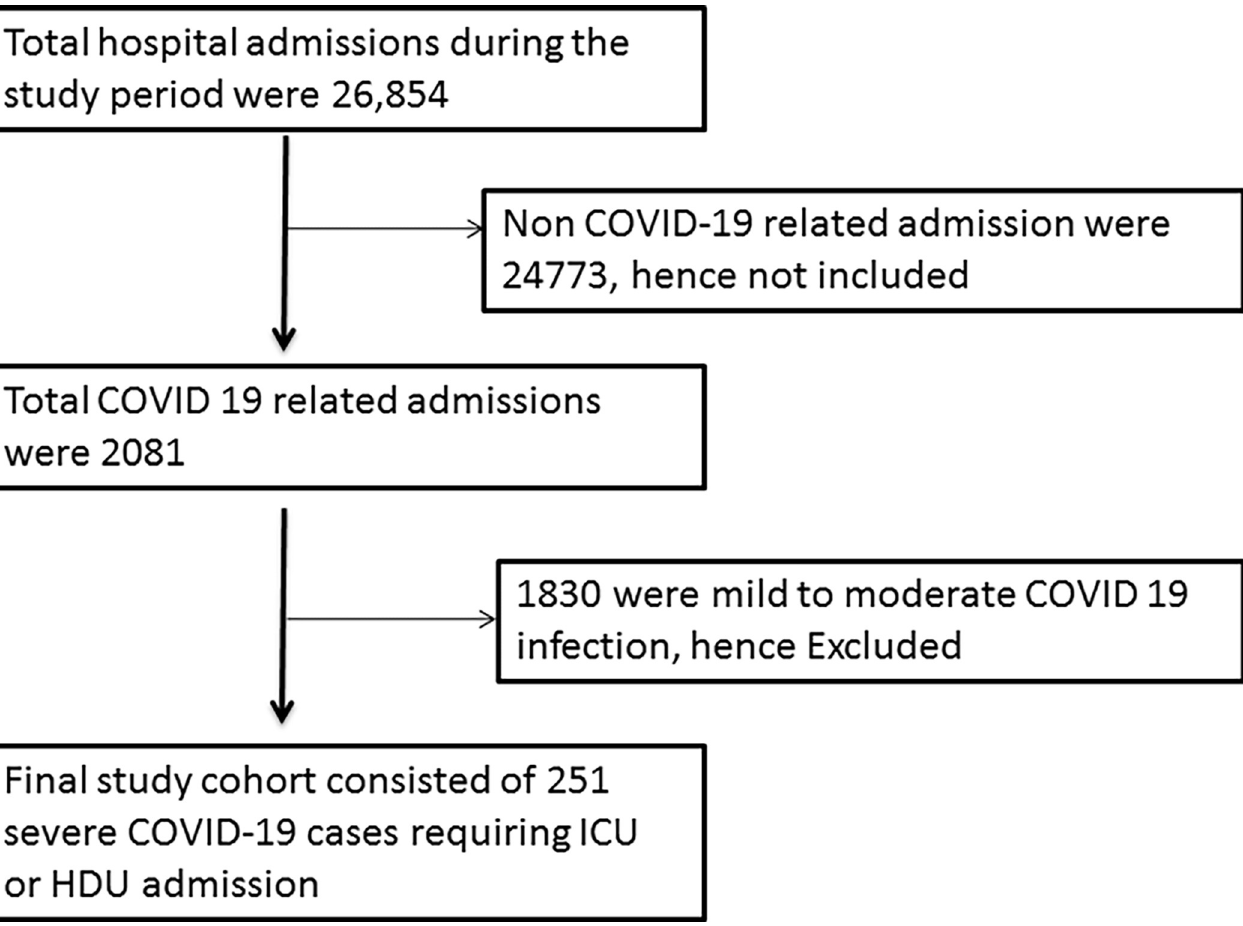
Fig 1. Showing flowchart of the study